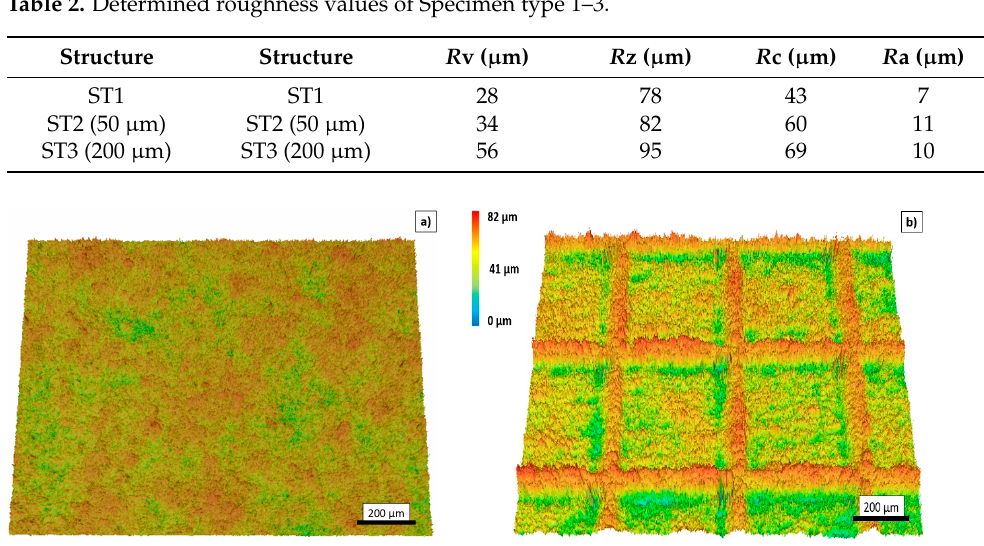
Figure 4. 3D illustrations of an unstructured bond coat ( a ) and an exemplary grid structure ( b ). The results of the roughness measurement show that the roughness of the structured specimen (ST2 and ST3) is larger compared to the unstructured sample (ST1). The arith- metic mean roughness R a increases from 7 to 10 and 11 µm, and the average height R c profile depth R v can also be observed. Table 2. Determined roughness values of Specimen type